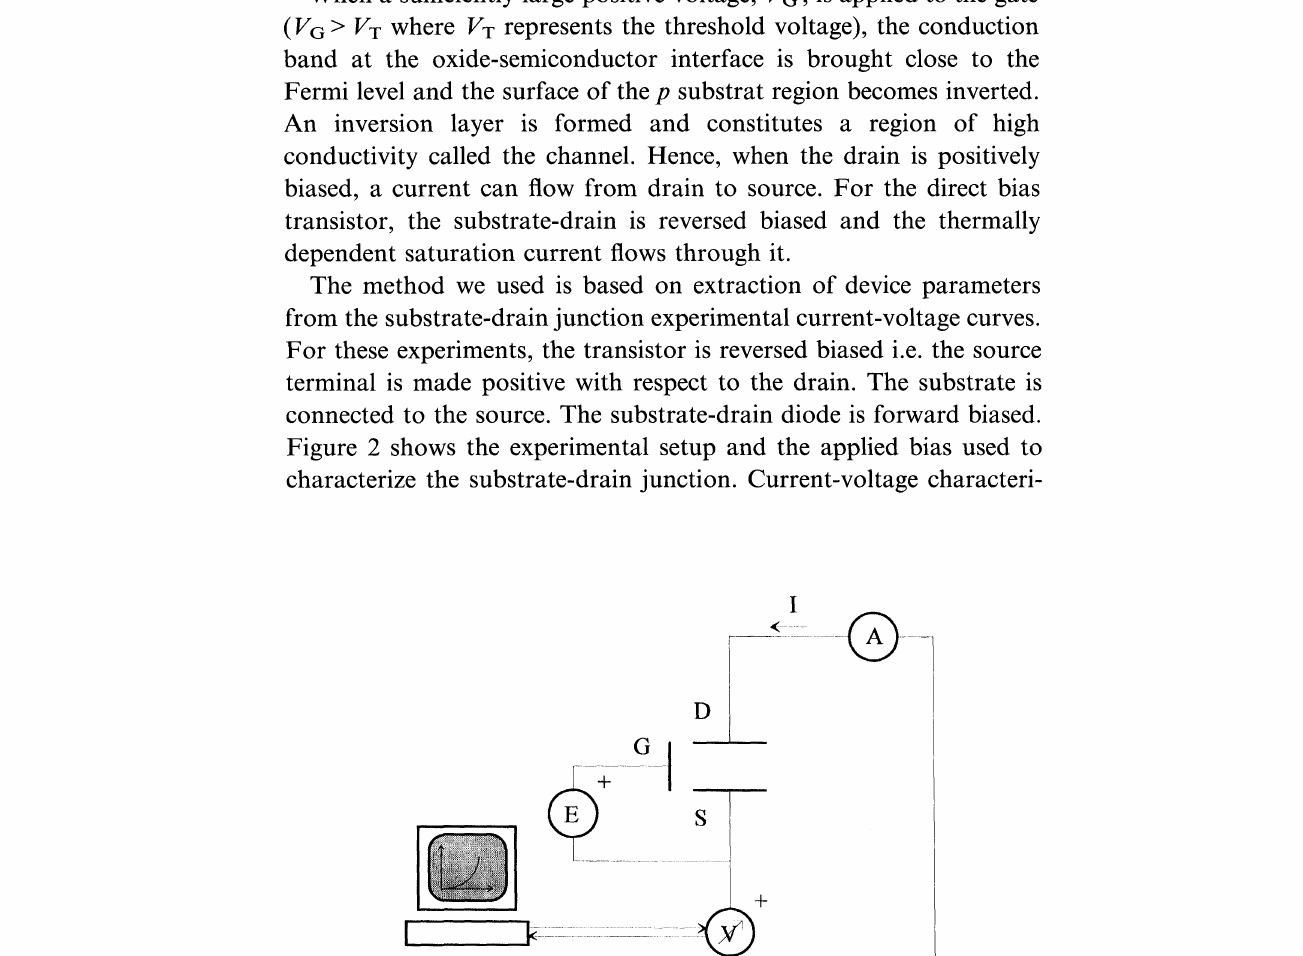
FIGURE 2 Diagram of a transistor biased for substrate-drainjunction